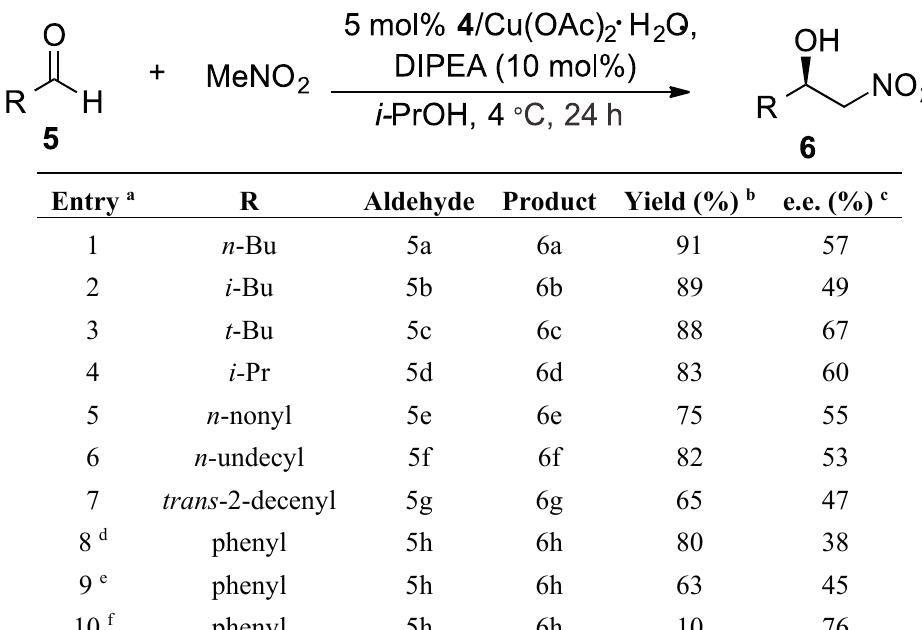
Table 2. Enantioselective Henry reaction of various aldehydes with nitromethane.